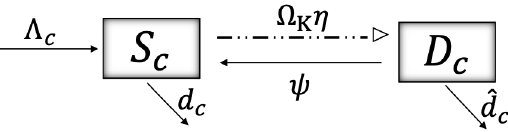
Figure 3. The schematic shows the flow between the states of an aquatic ecosystem: susceptible to damage from ITNs fishing ( S c ) and damaged from ITNs fishing ( D c ). The transition from susceptible- to-damage to damaged occurs through a pulse at moments triggered by ITNs fishing (represented by a dashed-dotted-dotted line), and solid lines represent continuous rates. A description of the variables and parameters used can be found in Tables 1 and 2,